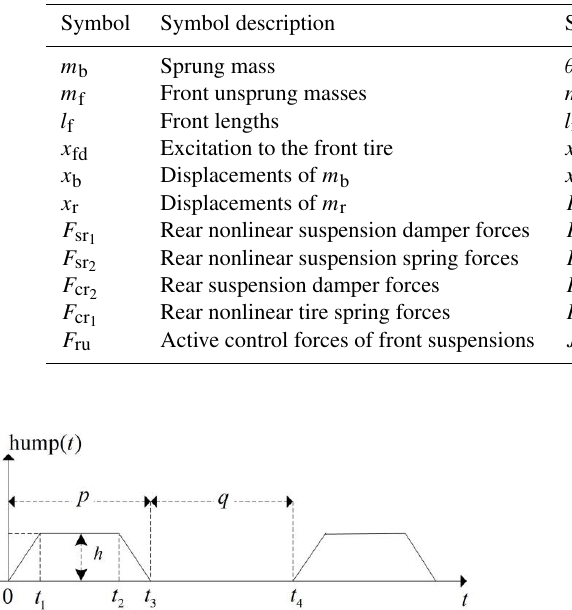
Table 1. Symbol description for the model.